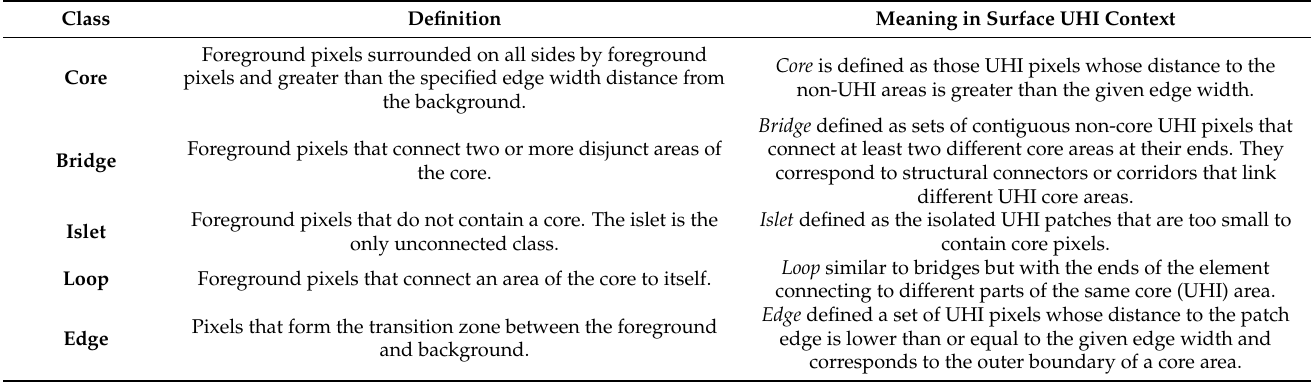
Figure 1. Illustration of the MSPA image classification of foreground pixels and legend. ( A )The image background pixel color is grey and non-UHI, the black pixel is UHI. ( B ) show the different types of “UHI” in the context of the MSPA classification. Table 1. Definition of morphological spatial pattern analysis (MSPA) classes and its meaning in the surface urban heat island (UHI)